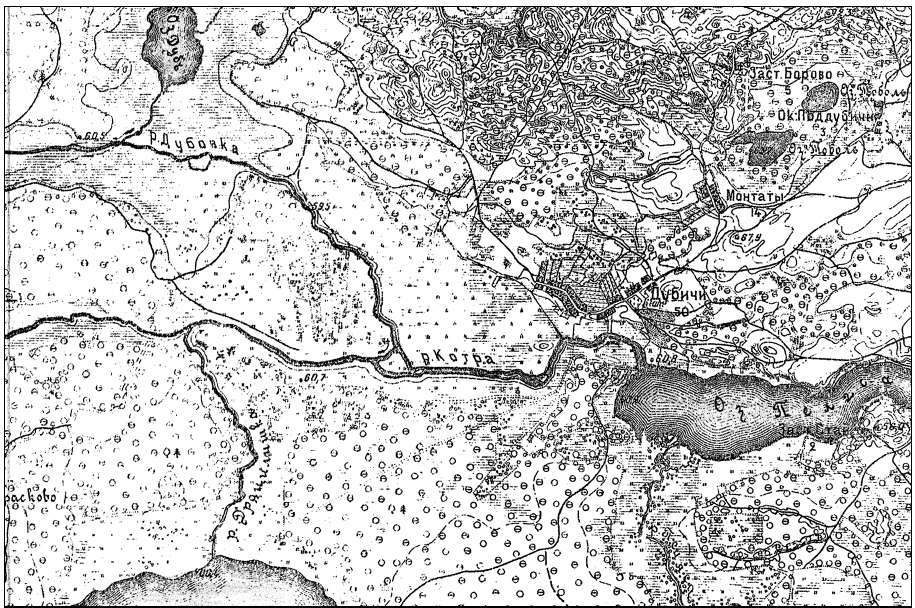
Fig 9. Fragment of map, page LXXII–3, scale 1: 42 000,